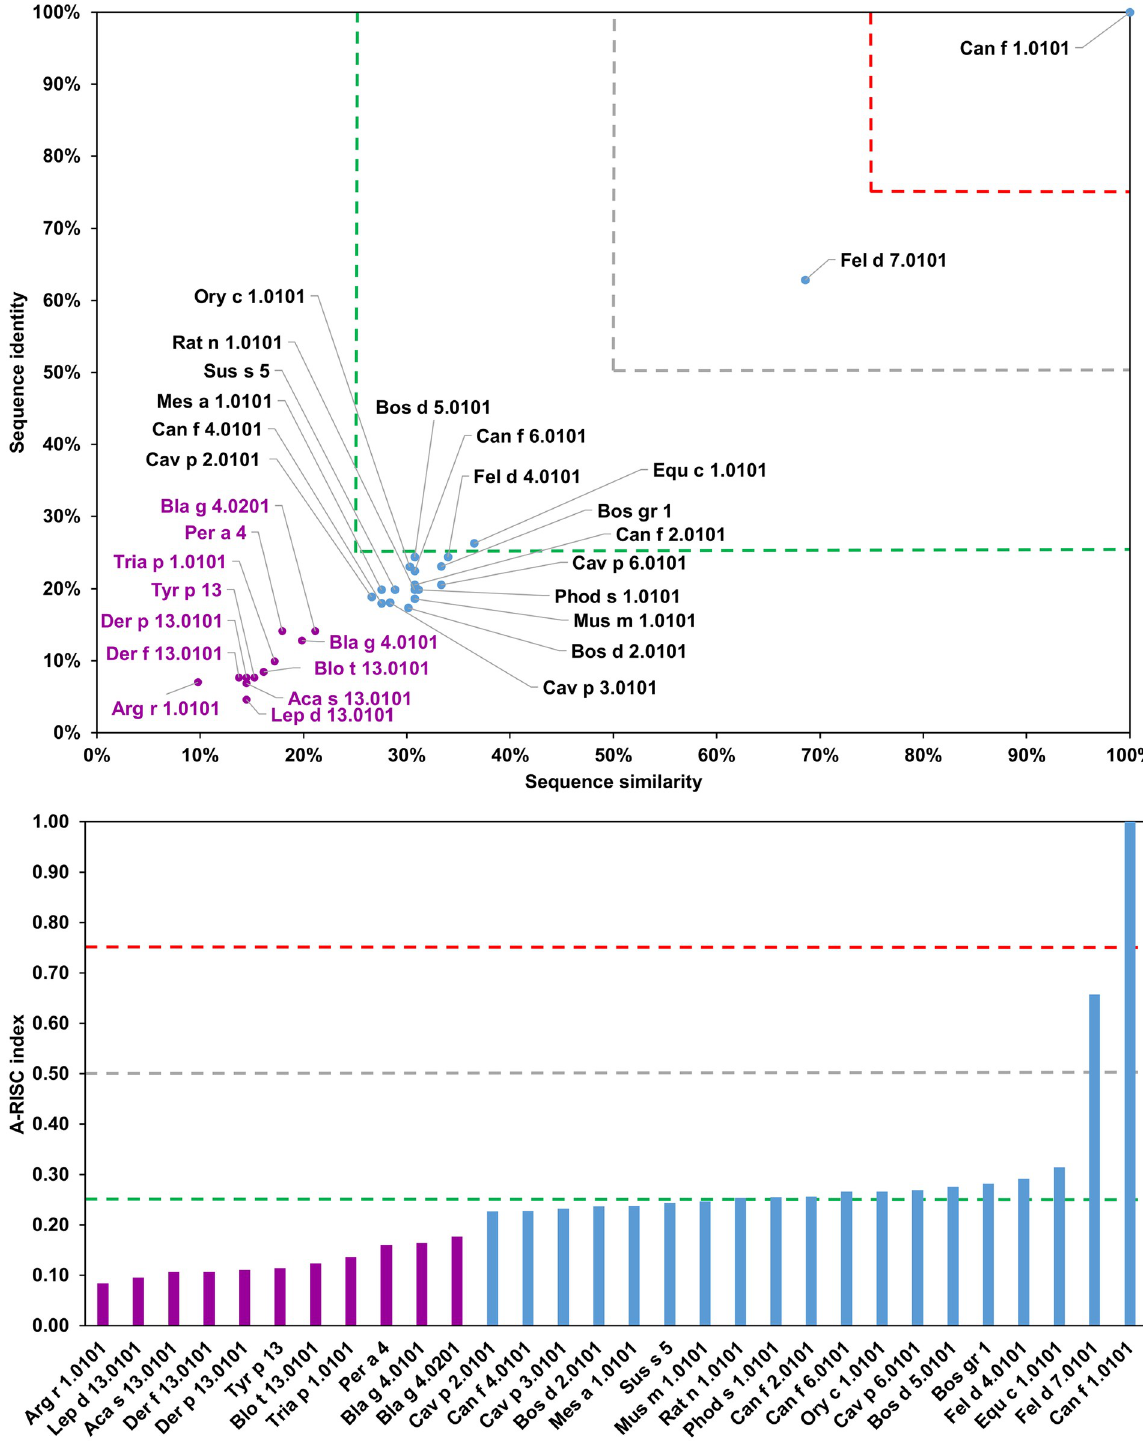
Fig 12. Plots showing relative homology and A-RISC indexes of allergens from lipocalin family of proteins. Comparison of family members to Can f 1.0101. Allergens originating from Arthropods are marked in purple, while mammalian lipocalins are shown in blue. Red, gray and dark green dashed lines indicate respectively 75%, 50% and 25% sequence identity and similarity, or 0.75, 0.50 and 0.25 A-RISC values.